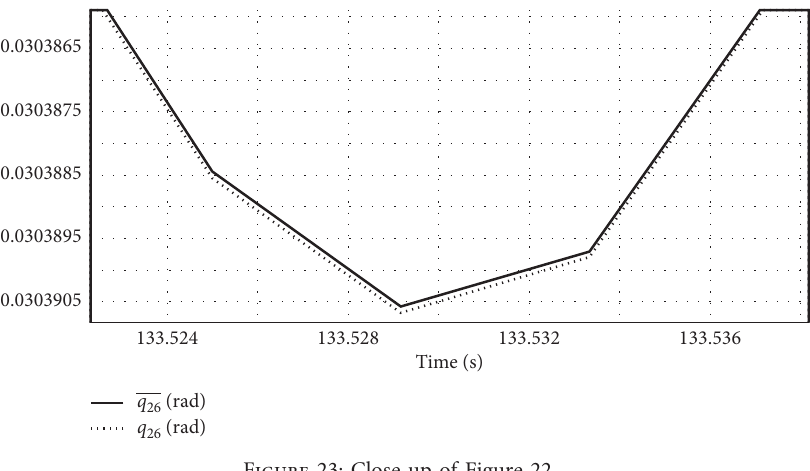
Figure 23: Close up of Figure